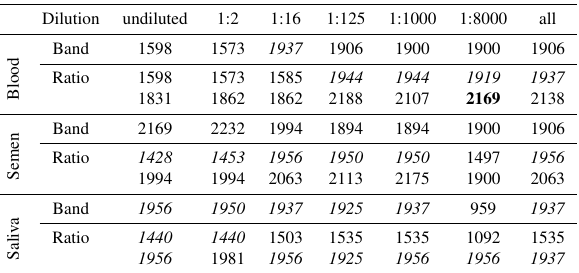
Table 1: Wavelengths with maximal Fisher’s ratios calculated for different methods (band, ratio) and different dilution rates of blood in SWIR-data, including accordances to established ab- sorption peaks as given in Table 2. Bold values indicate corre- spondences to trace-specific absorption peaks. Italic notation sig- nifies accordance to water peaks.